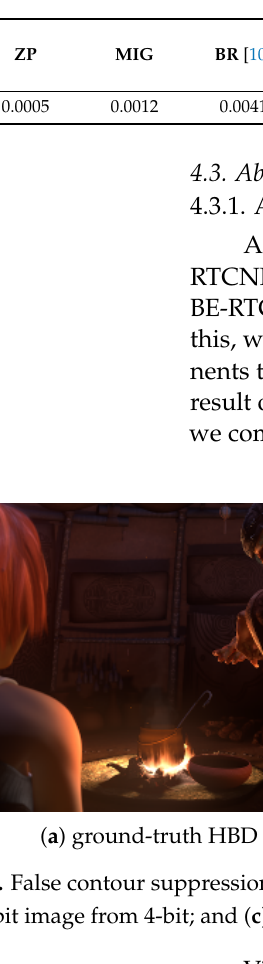
Table 2. Average run time (in seconds) of different algorithms.